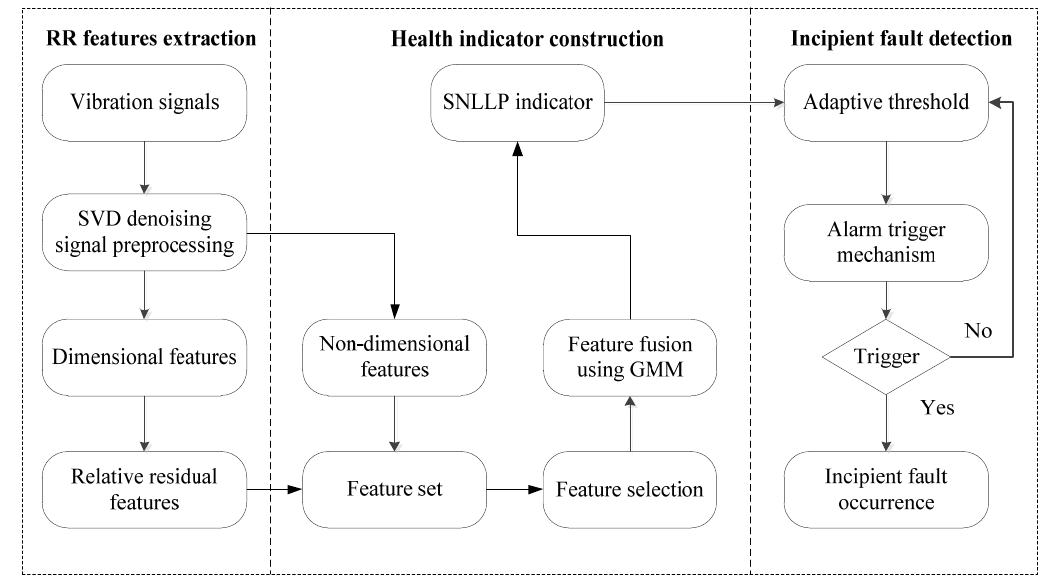
Figure 2. Flowchart of the proposed incipient fault detection method.